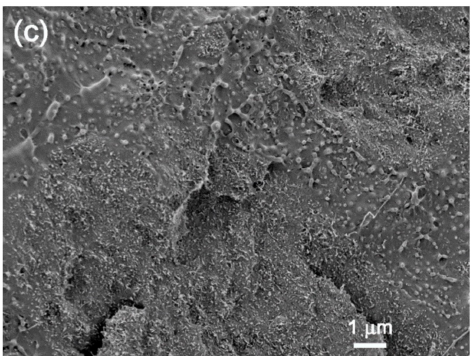
Figure 7. SEM micrographs for the PCL/(PC/MWCNT) nanocomposites, respectively, containing